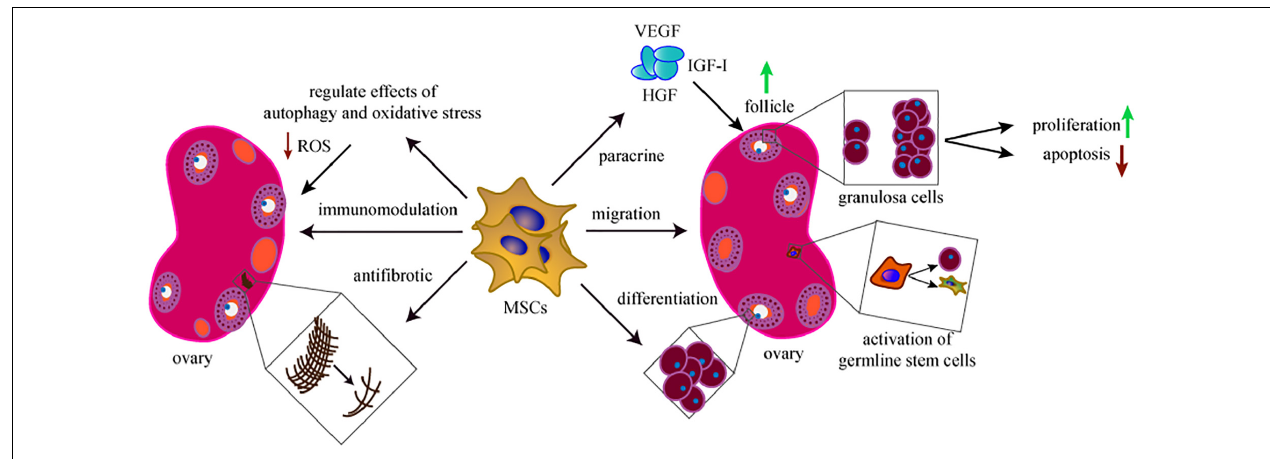
FIGURE 2 | The mechanisms of MSCs in treating POI. The therapeutic mechanisms behind the MSCs-based treatment include migration, proliferation, anti-apoptosis, paracrine, antifibrosis, immunomodulation, antifibrotic, and regulate the effects of autophagy and oxidative stress. Activation of germline stem cells is also involved in this